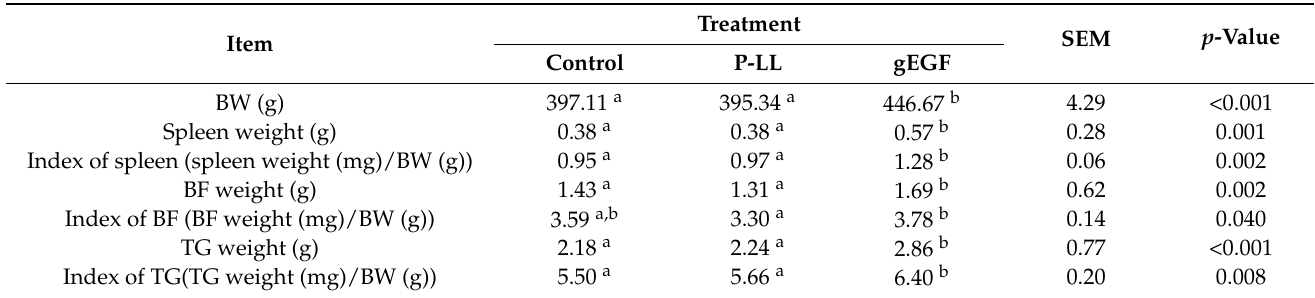
Table 3. Effects of gEGF on the indices of immune organs of treated broilers in two weeks of treatment. SEM: Standard Error of Mean; BF: bursa of Fabricius; TG: Thymus gland. Data represented mean of 3 replications per treatment with 3 broilers per replication ( n = 3). Means within a row without superscripts (a or b) were of no significant difference ( p > 0.05). Means within a row with different superscripts (a or b) differed significantly ( p < 0.05).